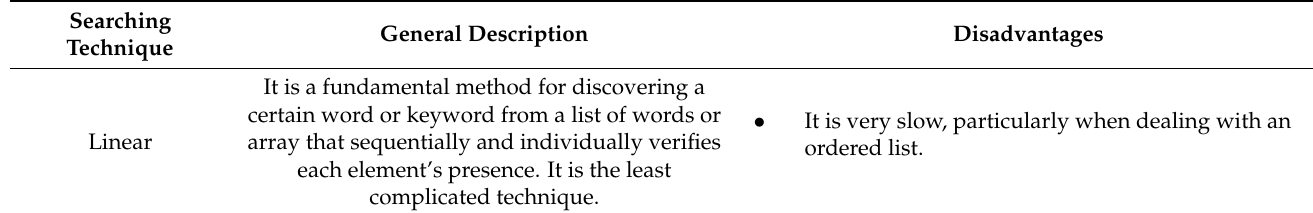
Table 3. General description and disadvantages of searching